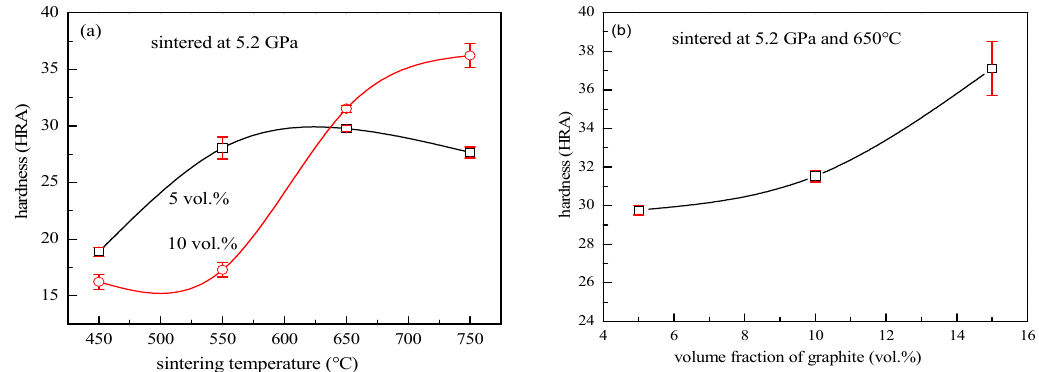
Figure 7. E ff ect of ( a ) sintering temperature and ( b ) graphite content on the hardness of the G / 6061Al.